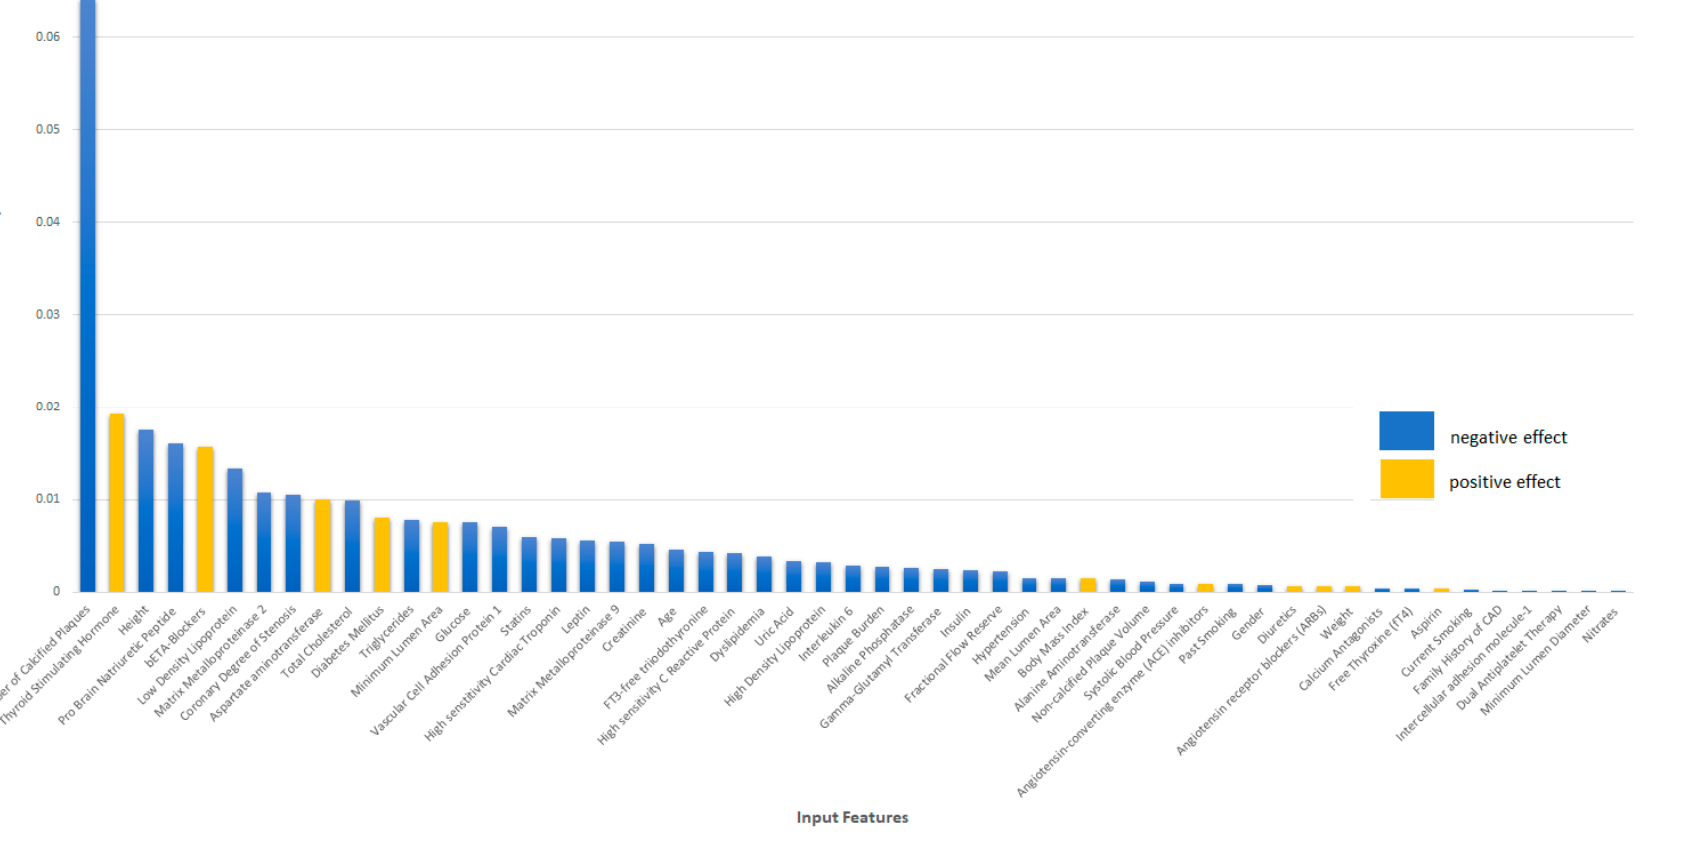
Figure 5. Input Features Contribution Table (blue, features with negative effect; yellow, features with positive effect). The most significant features that contribute positively to the output target are thyroid stimulating hormone, medication therapy of beta blockers, aspartate aminotransferase, diabetes, and minimum lumen area, whereas the most significant feature with negative effect on the output is the number of the calcified plaques at the baseline analysis of patient imaging.